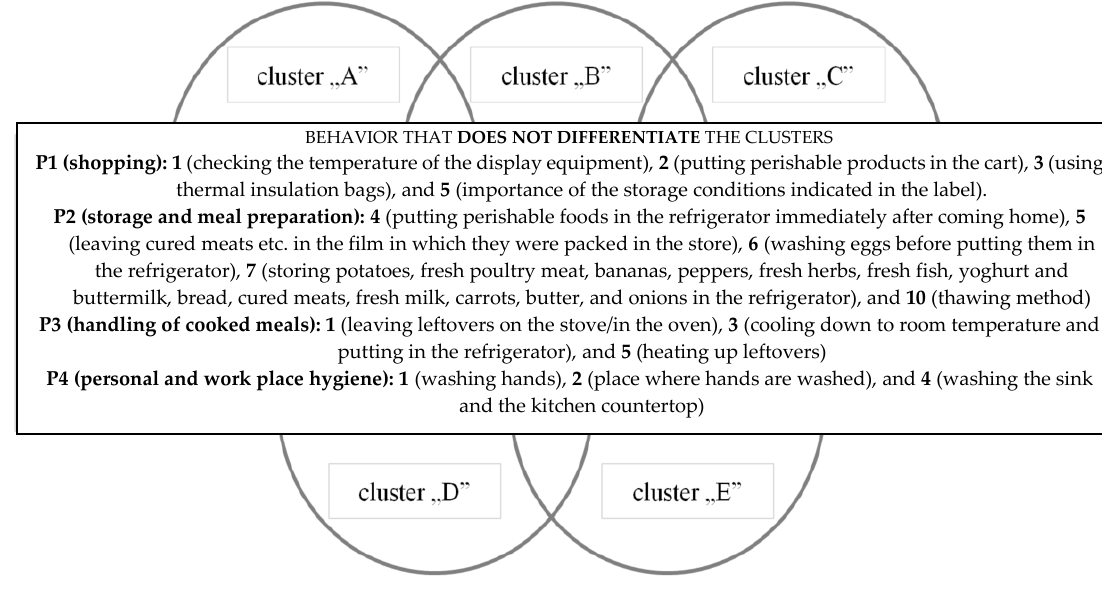
Figure 3. Behavior of respondents common to the clusters.